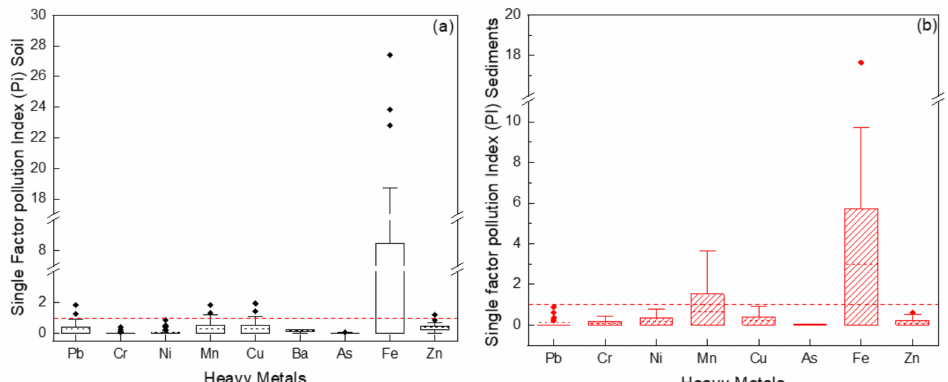
Figure 2. ( a ) Box plot of single factor pollution index (P i ) of Pb, Cr, Ni, Mn, Cu, Ba, As, Fe, and Zn in Romblon Municipality for soil; ( b ) Box plot of single factor pollution index (P i ) of Pb, Cr, Ni, Mn, Cu, Ba, As, Fe, Zn in Romblon Municipality for